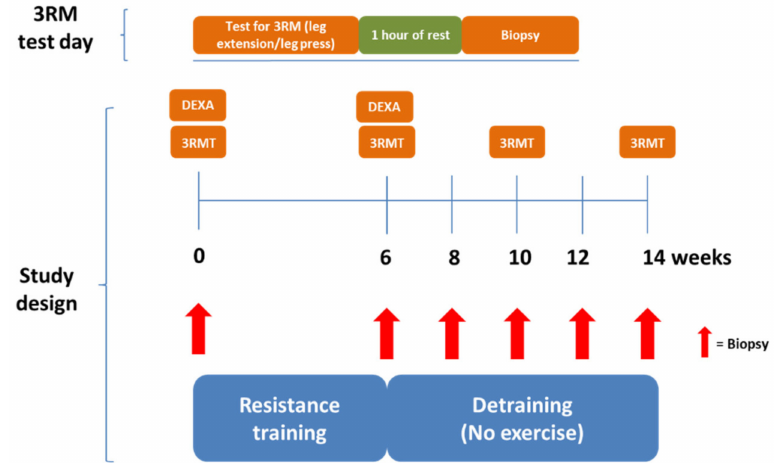
Figure1. Studydesignoverview. Eighteenparticipantscompletedasix-weekresistanceexercisetraining intervention followed by eight weeks of deconditioning (detraining—no exercise). Muscle strength was evaluated by a three-repetition max test before and after resistance exercise training. Skeletal muscle biopsies were taken from the vastus lateralis muscle on each test day. Furthermore, a biopsy was taken after two, four, and six weeks of